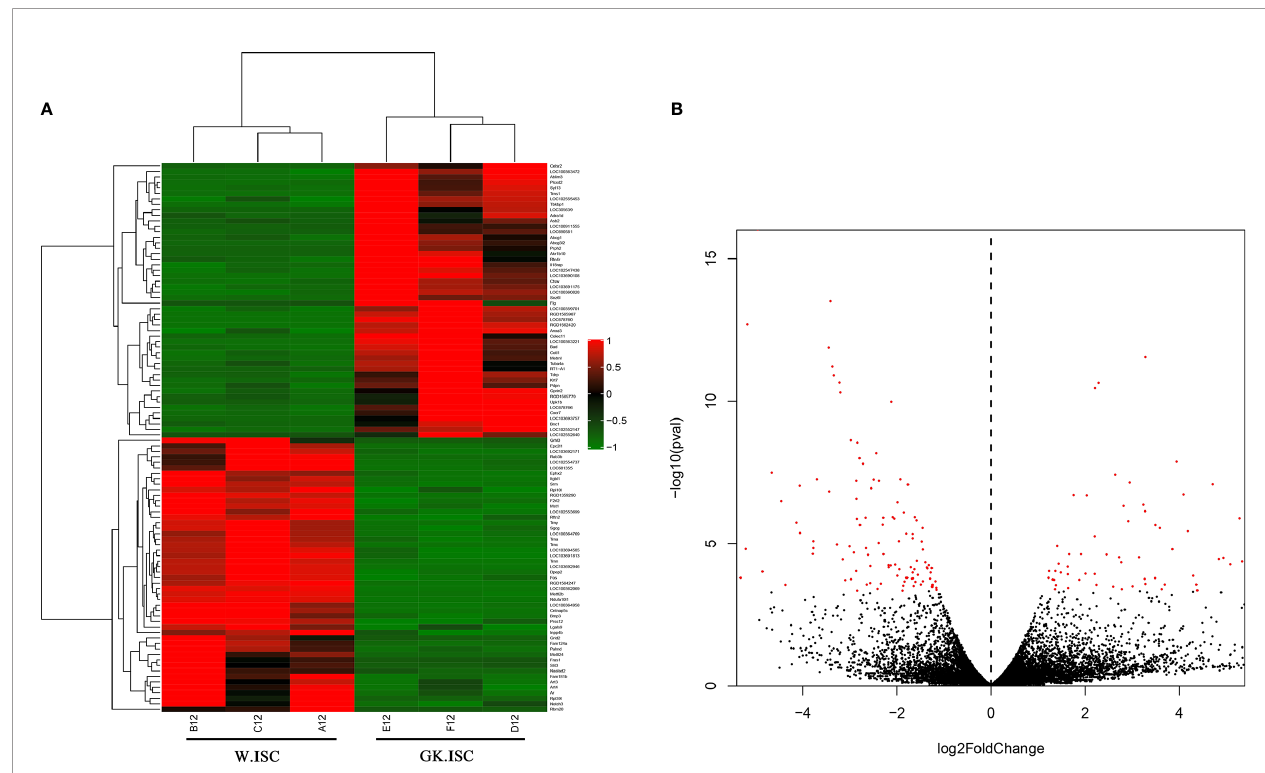
FIGURE 1 | Heatmap and Volcano plot showing DEGs in W.ISCs and GK.ISCs. (A) Heatmap shows the hierarchically clustered top100 differentially expressed genes. Up-regulated levels of gene expression are displayed as red bars while down-regulated levels are displayed as green bars. (B) Volcano plot shows the overall distribution of DEGs. Genes with fold change > 2 and statistical signi fi cance are marked with red